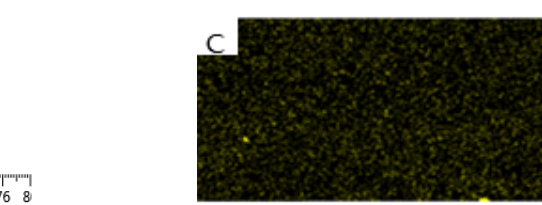
Figure 7. Element distribution in the interface between Inconel 718 and HT250 obtained by EDS.